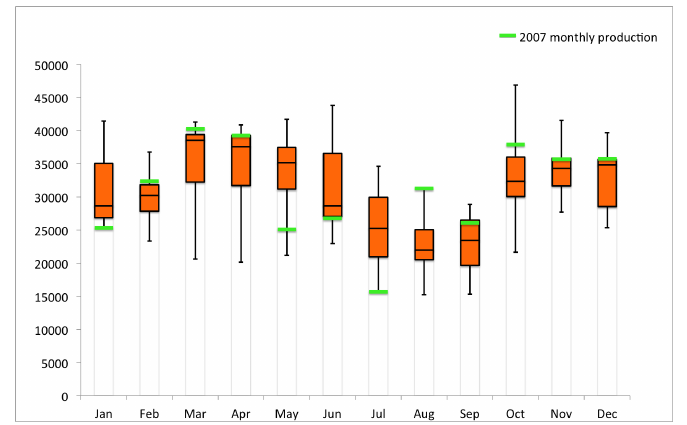
Figure 2. The whisker-box of the wind energy production (in units of megawatthours) in Callahan Divide Energy Center, TX, United States, during 2007–2016. The green bar denotes the production in